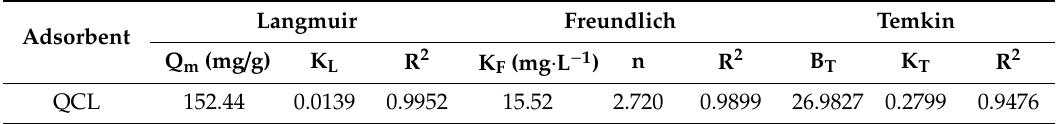
Table 3. Comparison of adsorption capacity of QCLF with other available different adsorbents.